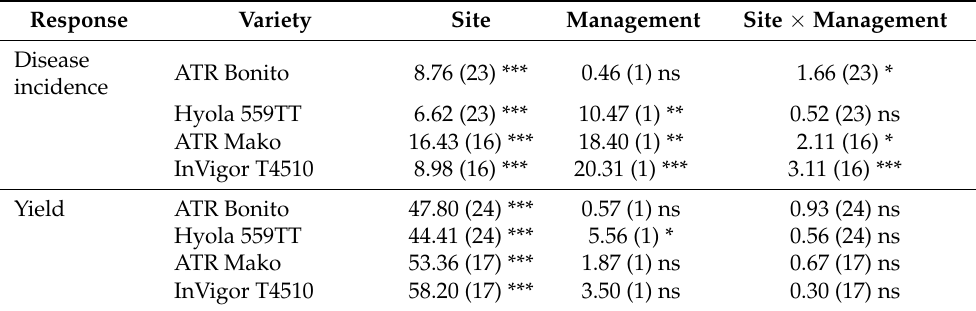
Table 3. Summary of treatment main effects and interactions on SSR disease incidence (proportion of infected plants) and canola yield (t/ha) for four varieties (ATR Bonito, Hyola 559TT, ATR Mako and InVigor T4510). Variance ratio and degrees of freedom (in brackets) are presented. Signifi-